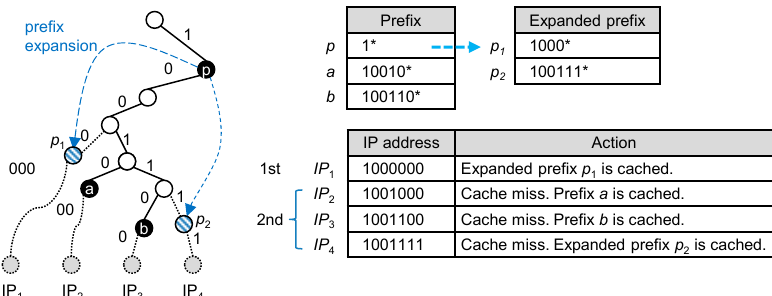
Figure 2. Example of prefix expansion to resolve the problem in Figure 1. When IP 1 arrives, the non-leaf prefix p is expanded to p 1 , which is independent of other prefixes.